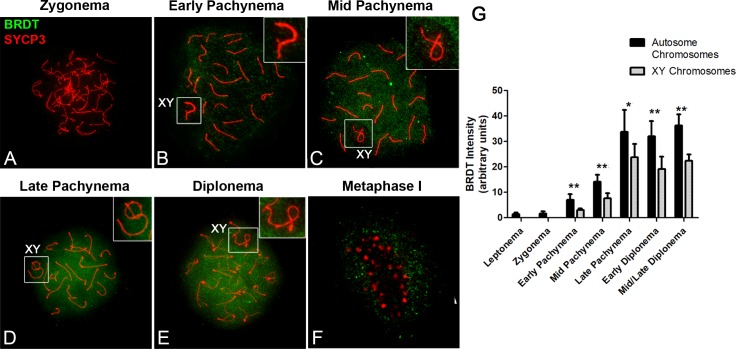
Pattern of BRDT protein expression during late stages of prophase I in male meiosis.(A-F) Immunolocalization of BRDT (green) and SYCP3 (red) during prophase I and metaphase I in WT spermatocyte spreads. Right upper insets show enlargements of the X and Y sex chromosomes (XY body) outlined in B—E. (A) BRDT signal is absent in zygonema. (B) BRDT is faintly detected in early pachynema. (C,D) In mid and late pachytene, and (E) diplotene spermatocytes, BRDT appears as a strong signal throughout the chromatin of autosome chromosomes and weakly in the XY body (upper right inset in C-E). (F) In metaphase I, BRDT is faintly observed in the cytoplasm. (G) Quantification of the signal intensity of BRDT in the chromatin of autosomes and sex chromosomes during each stage of prophase I. *p<0.05, **p<0.01. Error bars indicate standard deviation. Spreads were prepared from three 3 month-old WT mice; n = 10 leptotene, 10 zygotene, 20 early pachytene, 30 mid pachynema, late pachynema, early diplonema and mid/late diplonema spermatocytes respectively per each mouse.